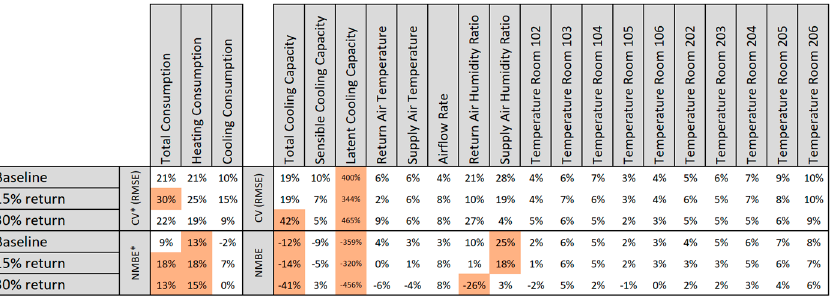
Table 12. CV (RMSE) and NMBE Calculations for Detailed Model Outputs: Return Air Duct Leakage.